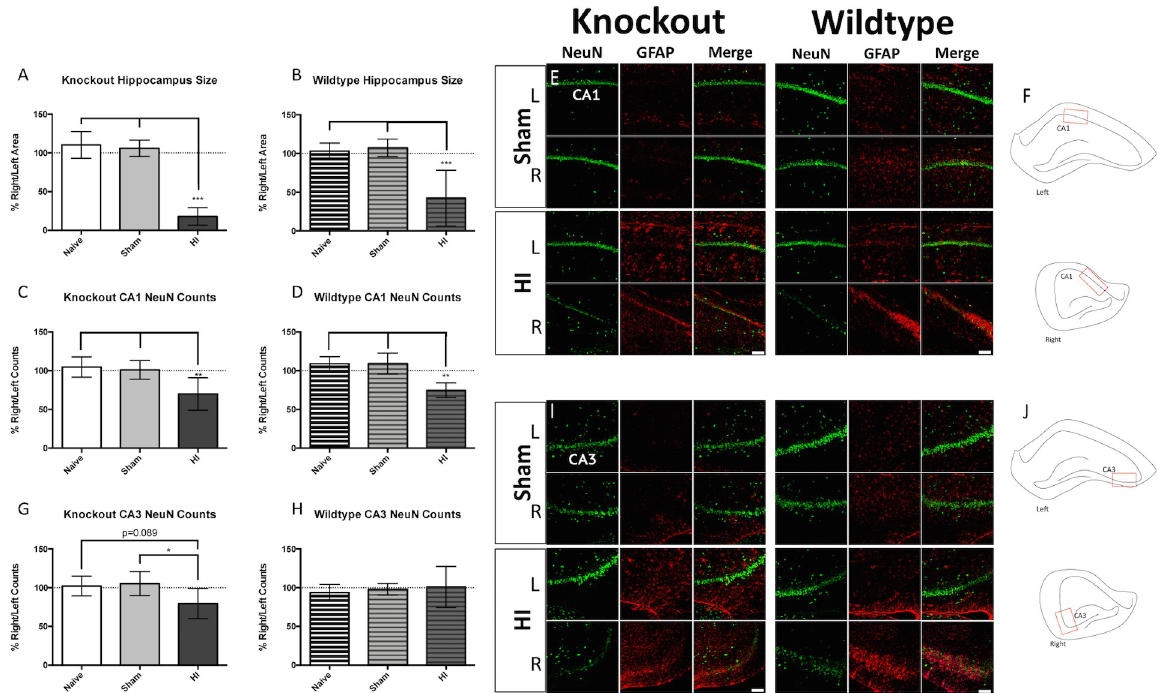
Fig 4. Hippocampal injury. Injured Prkdc KO (A) and WT (B) rats both exhibited reductions in right hippocampal area. Both KO (C) and WT (D) injured rats also display reductions in the number of neurons in the right CA1 pyramidal layer. Representative immunofluorescence in CA1 of KO Sham (E top left), KO injured (E bottom left), WT Sham (E top right), and WT injured (E bottom right) in the right and left hemispheres. Where neuronal loss was observed, astrogliosis was evident (green = NeuN, red = GFAP). (F) Measurement locations for CA1 neuronal counts (red boxes) are shown for the left and right hemispheres; A trend toward reduction in neurons in the right CA3 pyramidal layer was observed in KO (G), but not in WT (H) injured rats. Representative immunofluorescence in CA3 of KO Sham (I top left), KO injured (I bottom left), WT Sham (I top right), and WT injured (I bottom right) in the right and left hemispheres. Gliosis is also evident in these injured animals (green = NeuN, red = GFAP). (J) Measurement locations for CA3 neuronal counts (red boxes) are shown for the left and right hemispheres; Scale bars = 100 μ m, 20x. Error bars = ± SD. � p < 0.05, �� p < 0.01, ��� p < 0.001.